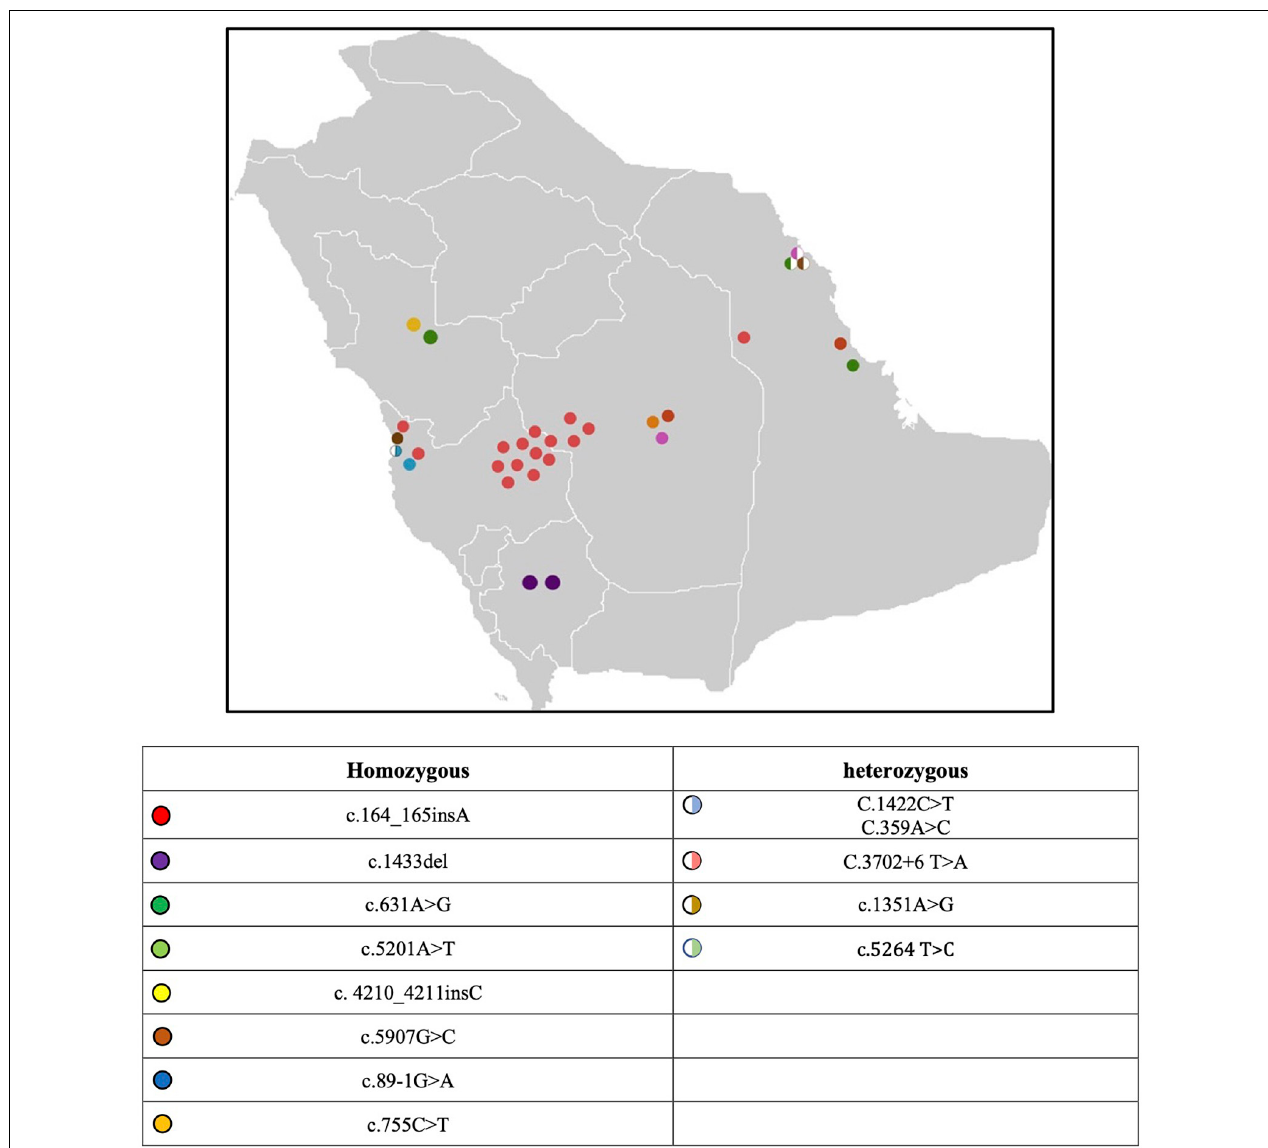
FIGURE 1 | Map of Saudi Arabia with the distribution of genetic